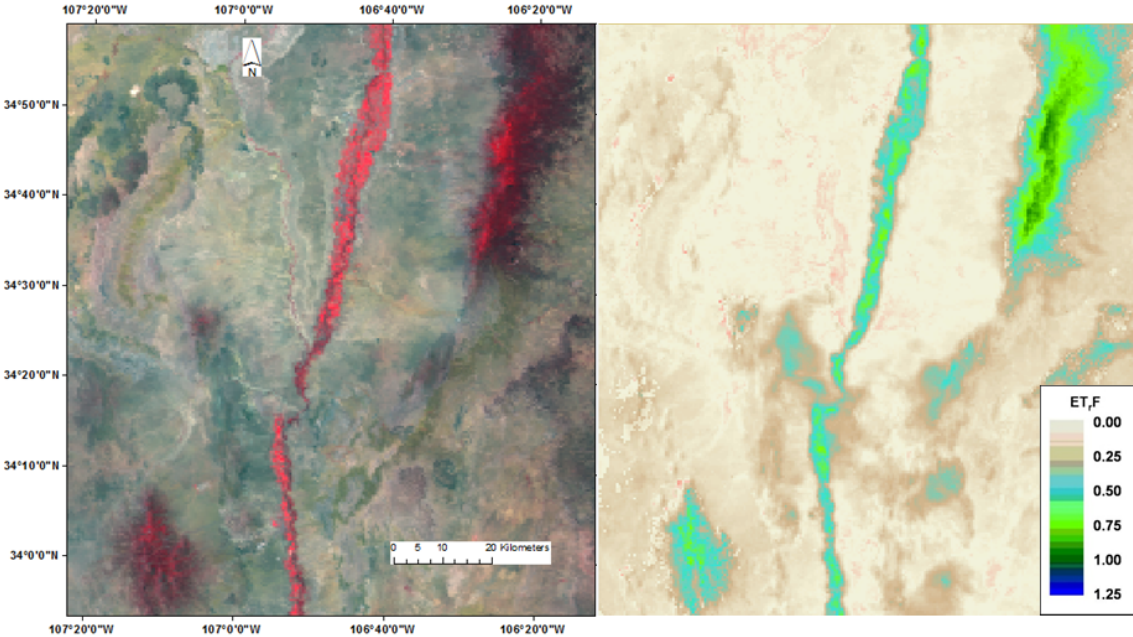
Figure 8. (Left ) false color MODIS image for 06/30/2007 (2,1,4 combination). ( Right ) corresponding ET F r